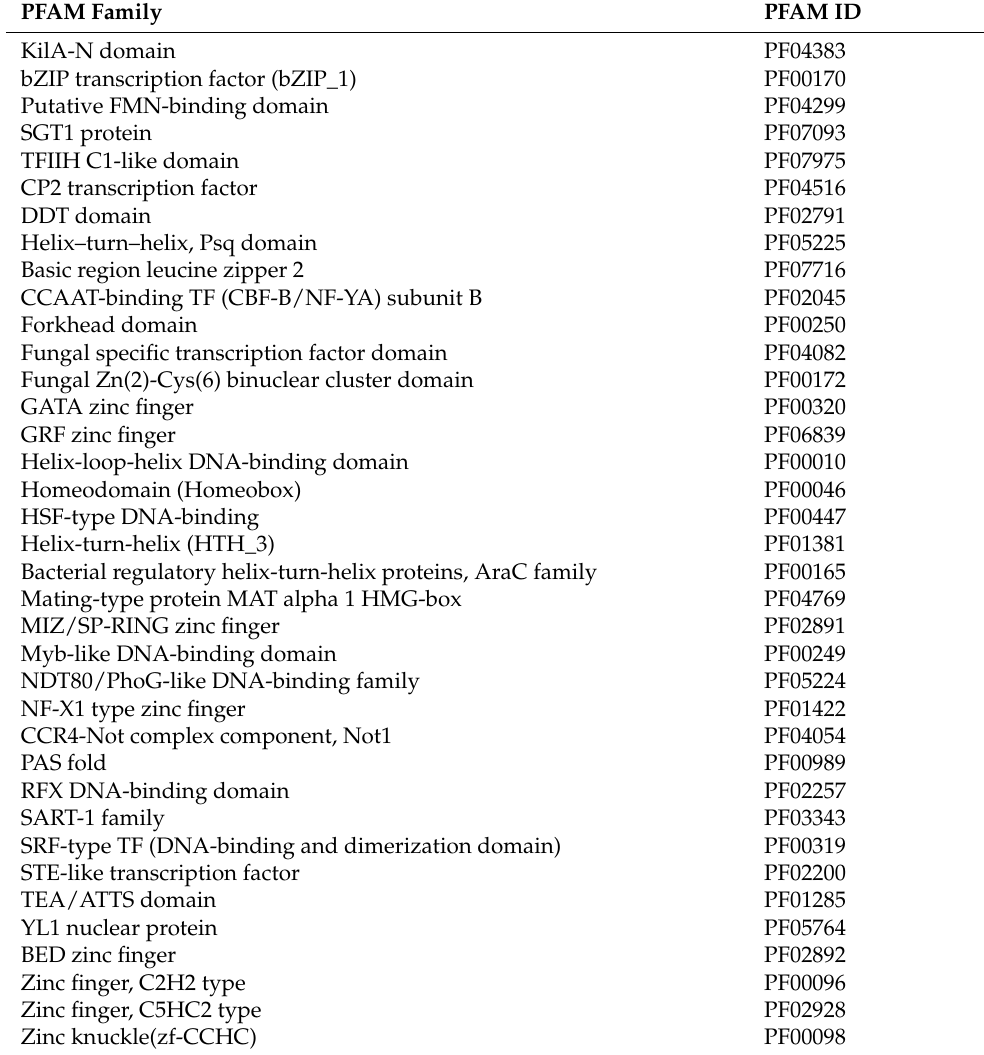
Table 1. Sixteen superfamilies and forty-five PFAM families of TF DNA binding domains predicted to occur in Aureobasidium spp. (except for general transcription factors, DNA repair/extend, nuclear receptor and chromatin